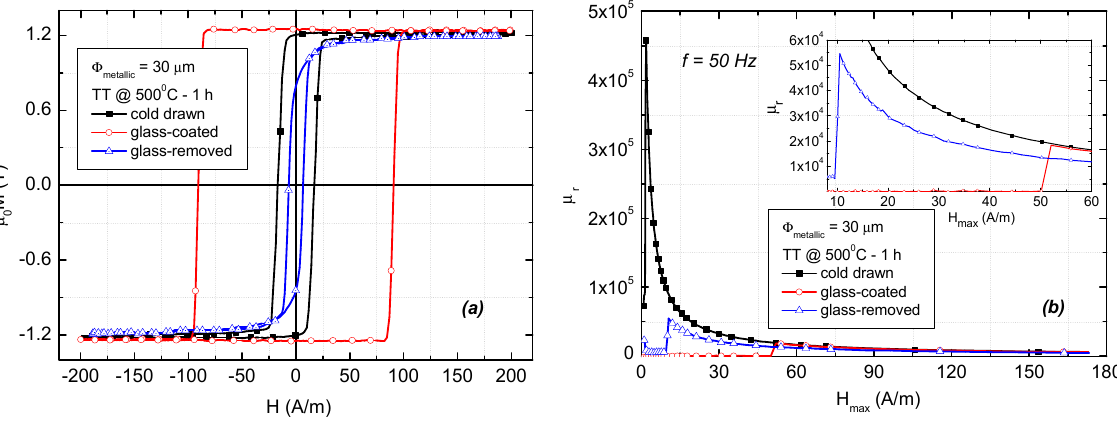
Figure 4. ( a ) Axial hysteresis loops and ( b ) variation of relative magnetic permeability with applied magnetic field for annealed (500 °C—1 h) Fe 73.5 Si 13.5 B 9 Cu 1 Nb 3 microwires having 30 µm metallic core diameter. (Sample length: l s = 10 cm).